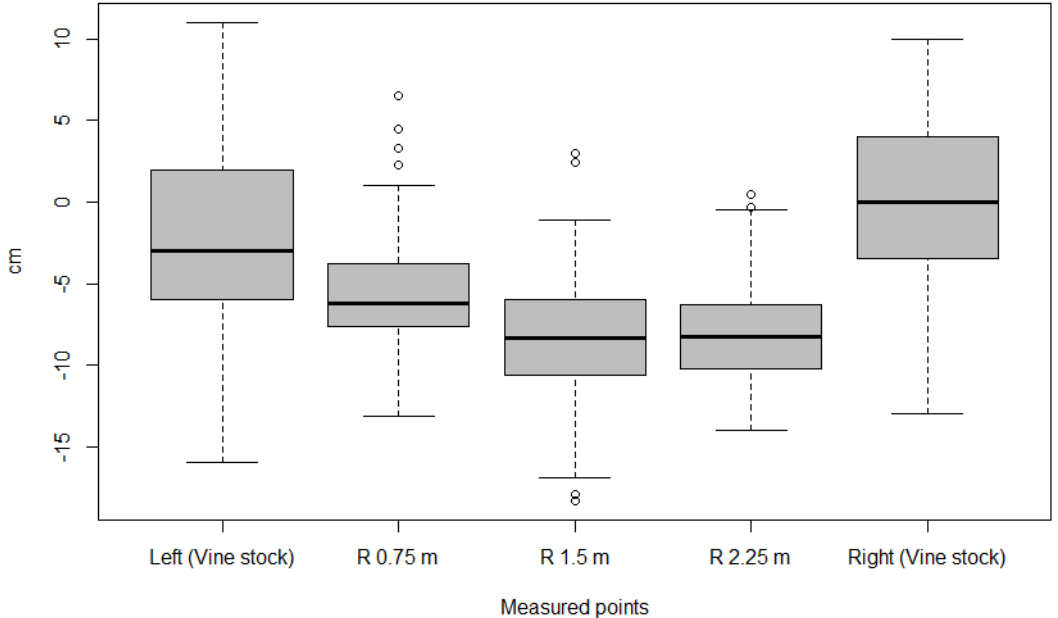
Figure 5. Box-plot graphic of graft union and inter-row measures (n = 670), representing the actual topsoil level on average for the whole Rías Baixas vineyard. R 0.75 m, R 1.5 m and R 2.25 m stands for the reference points measured within the inter-row at 0.75, 1.5 and 2.25 m, respectively, from the left vine stock.